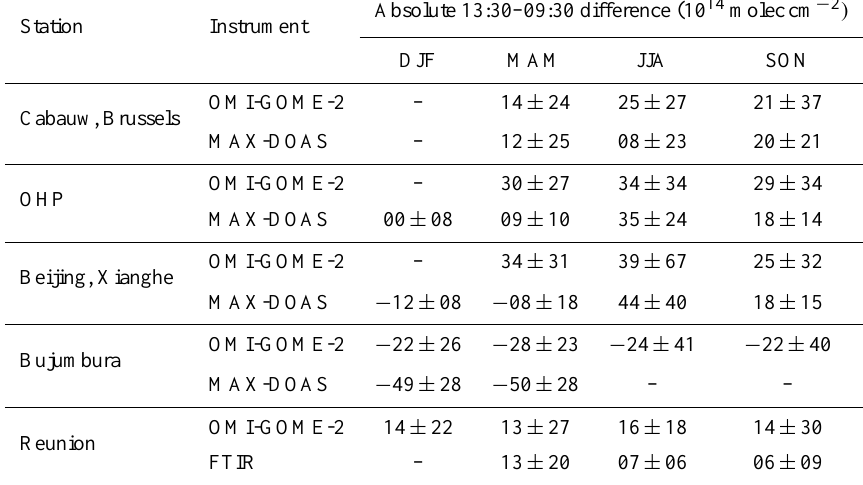
Table 4. Mean diurnal variations of the H 2 CO columns as observed with ground-based and satellite instruments. Values are given for five regions where BIRA-IASB operates ground-based measurements: Cabauw and Brussels, OHP, Beijing and Xianghe, and Bujumbura and Reunion. Details of the ground-based measurements are summarised in Table